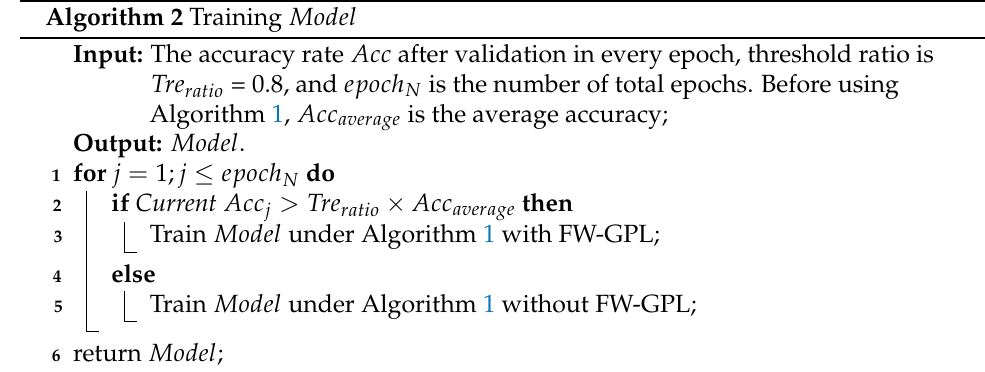
Algorithm 2 Training